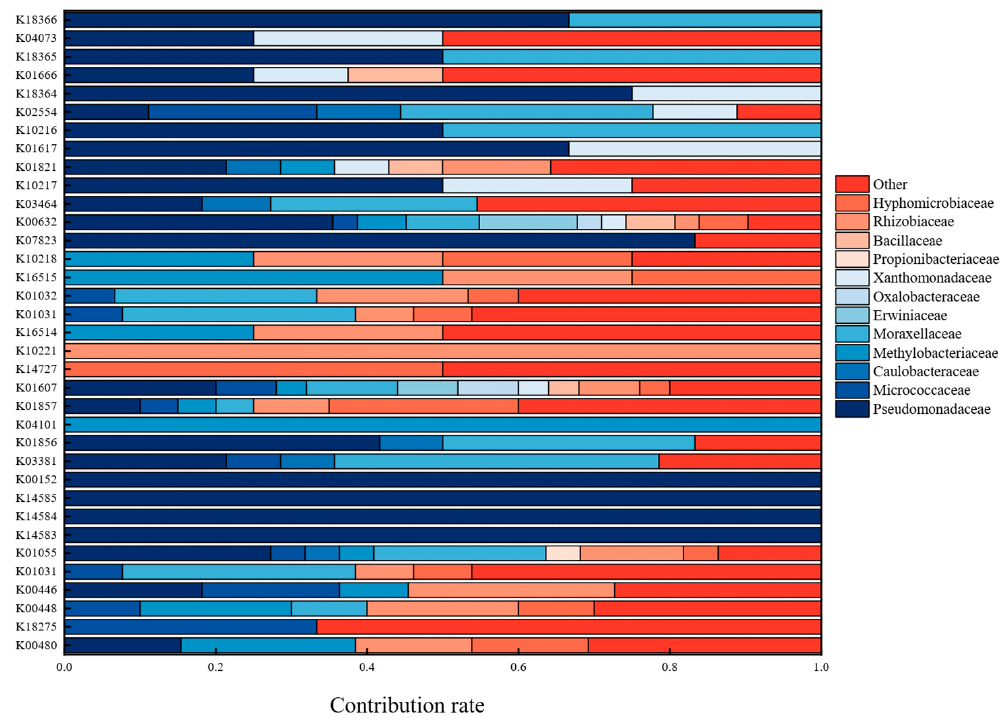
Figure 5. The contribution of bacteria (family) to PHE degradation pathway.